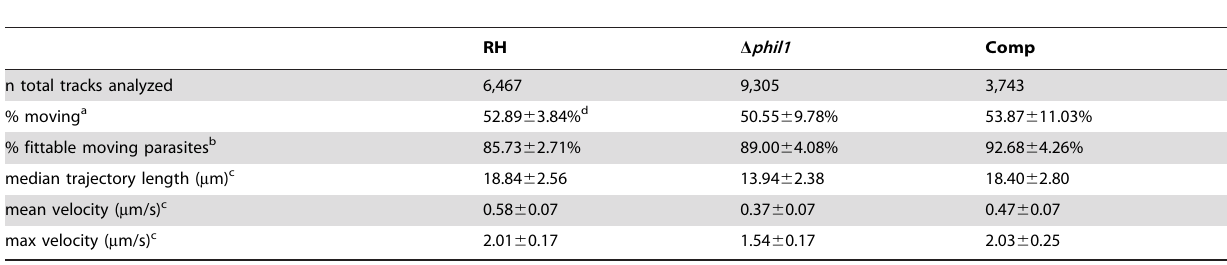
Table 1. Summary of 3D motility